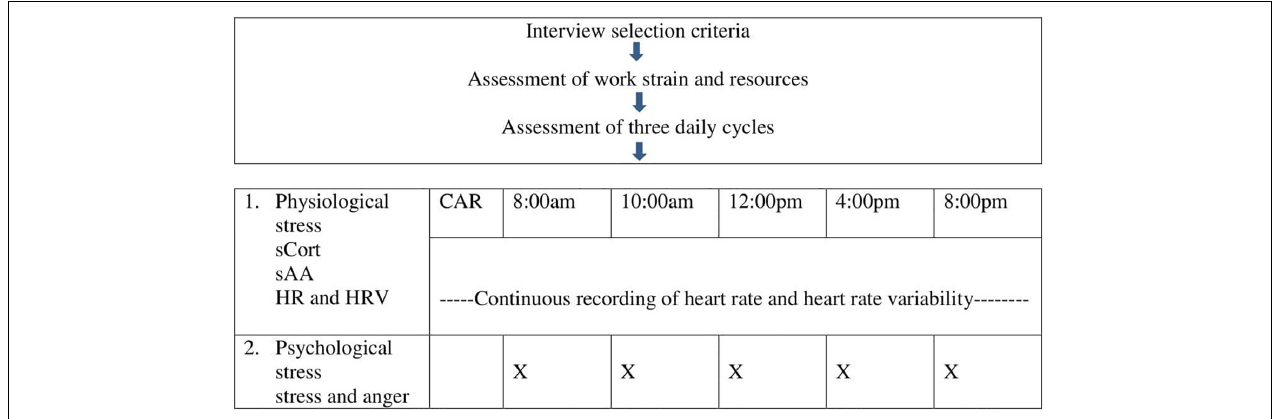
FIGURE 1 | Study design. sCort, salivary cortisol; CAR, cortisol awakening response after awakening, 30 and 45 min later; sAA, salivary alpha-amylase; HR, heart rate; HRV, heart rate